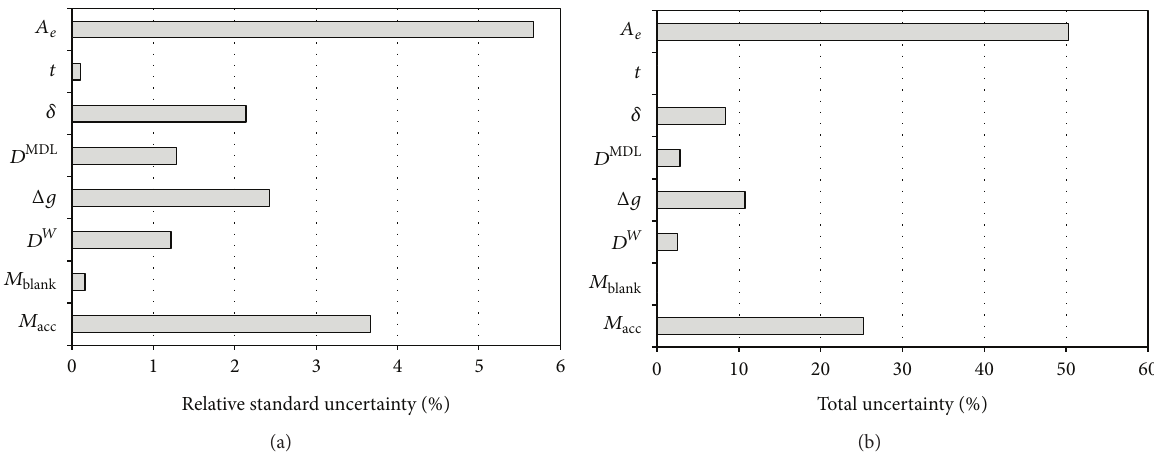
Figure 4: Relative standard uncertainty (a) and percentage of total uncertainty (b) for the variables in the model equation. Table 3: Uncertainty budget for 𝑀 showing relative uncertainties for the variables and the combined standard uncertainty. acc Symbol Source of uncertainty Type ∗ Standard uncertainty 𝑢(𝑥 𝑖 ) Distribution Divisor Relative uncertainty 𝑚 Estimated mass from ICP-MS analysis A 1.0 × 10 −8 g Normal 1 0.008 icp-ms 𝑟 Recovery factor B 0.0293 Rectangular √3 0.064 Uc (M) Combined standard uncertainty A 6.15 × 10 −8 g Normal 0.038 ∗ Note: type of uncertainty refers to types A and B, using standard vocabulary for statistically evaluated uncertainty (A) and uncertainty evaluated by other methods